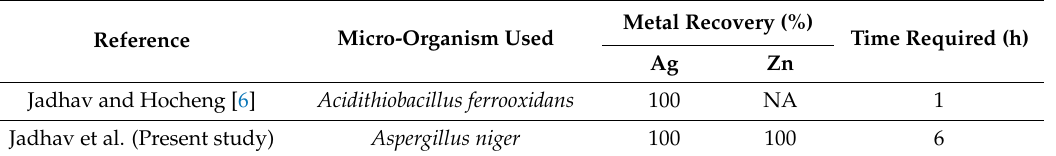
Table 2. A comparisons between current and earlier studies for recovery of metals from spent silver oxide-zinc button cell